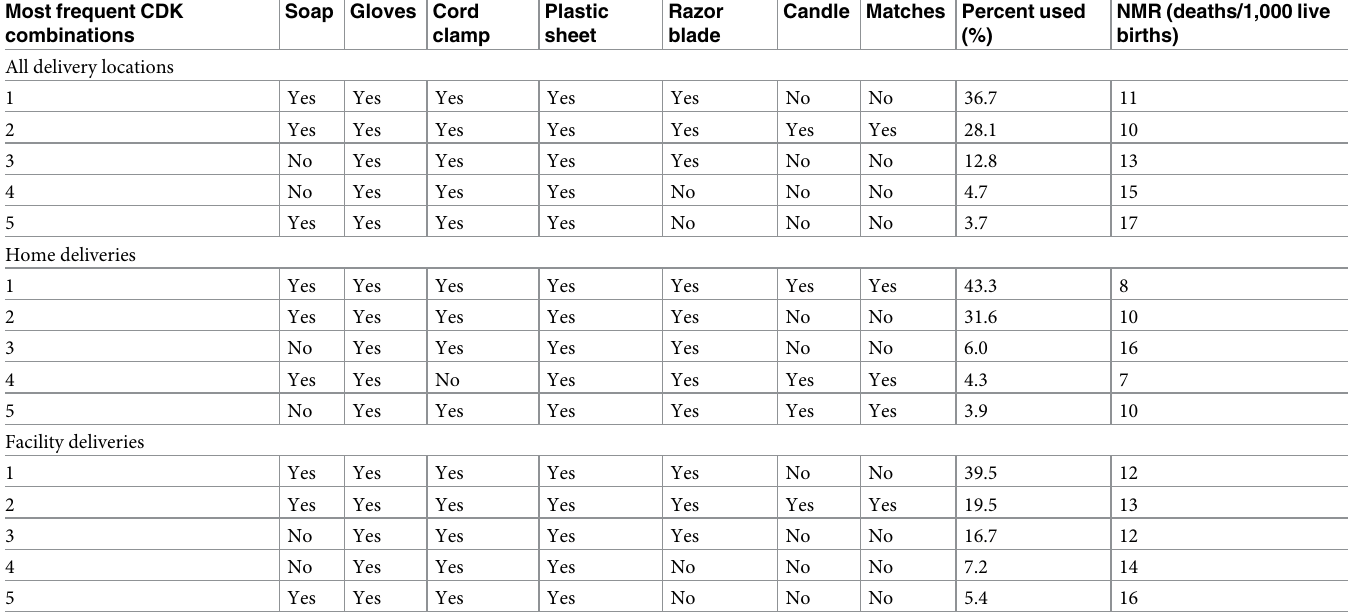
Table 3. CDK use by most common